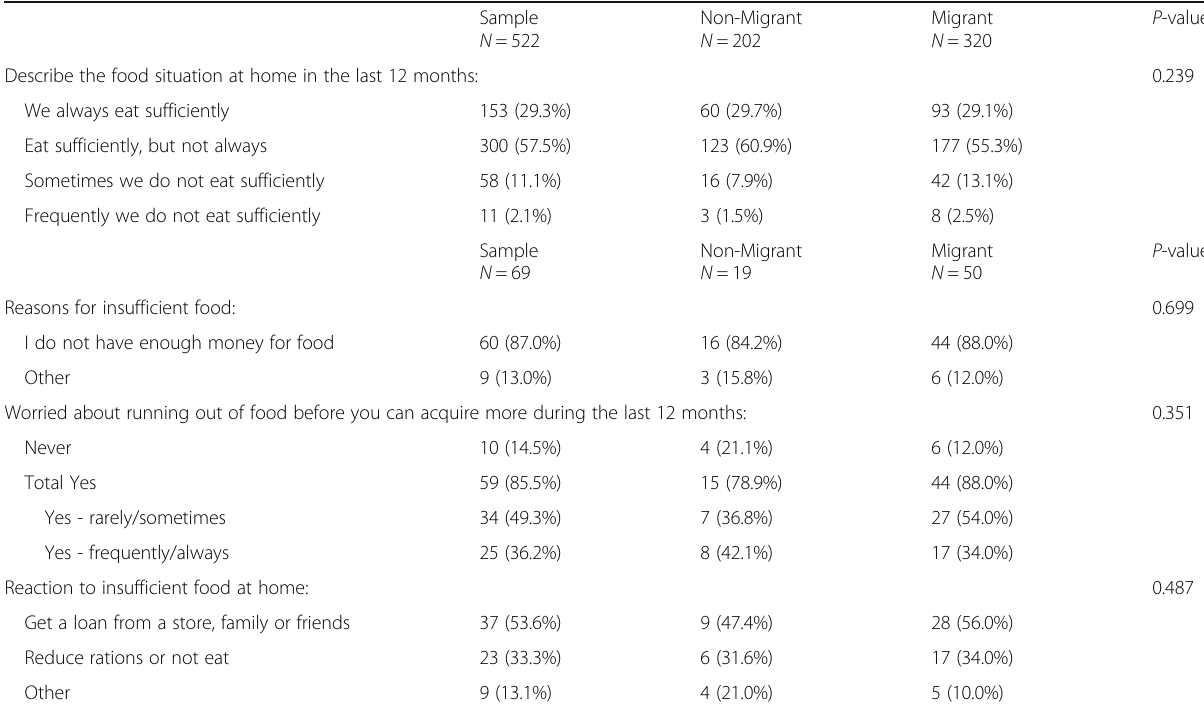
Table 2 Physical capital: Food access